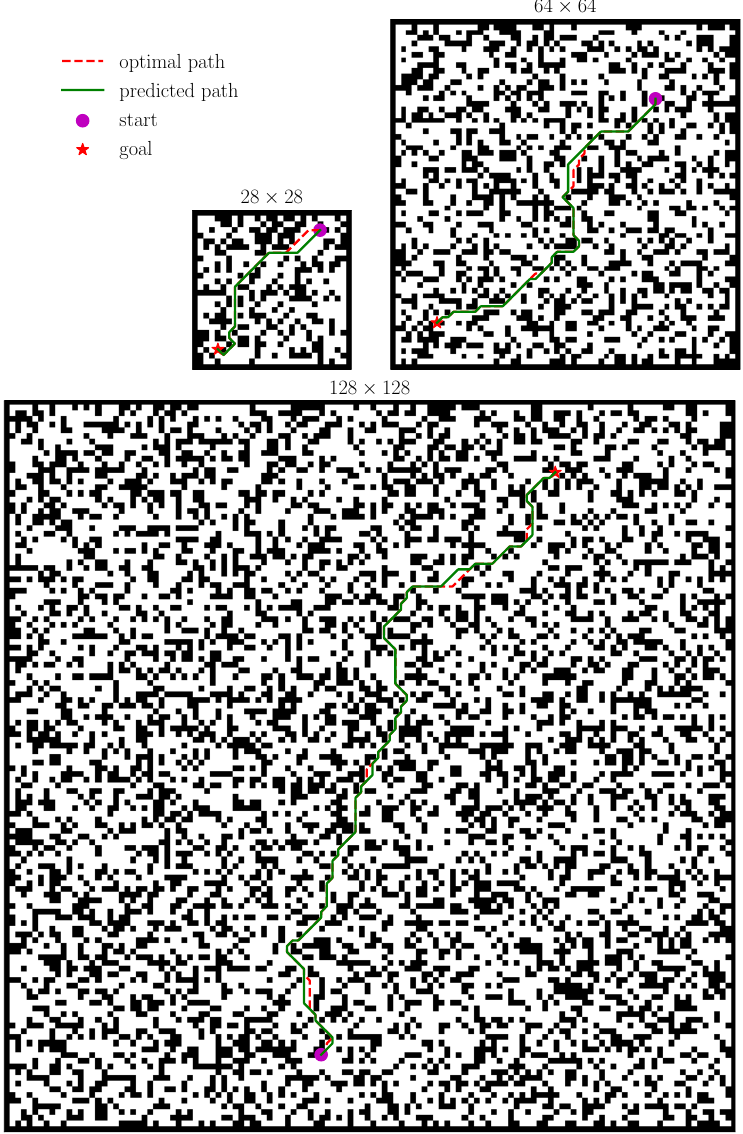
Figure 5. Random instances of grid-world domains with the size of 28 with the dVIN-predicted trajectories and ground-truth shortest paths between random start and goal